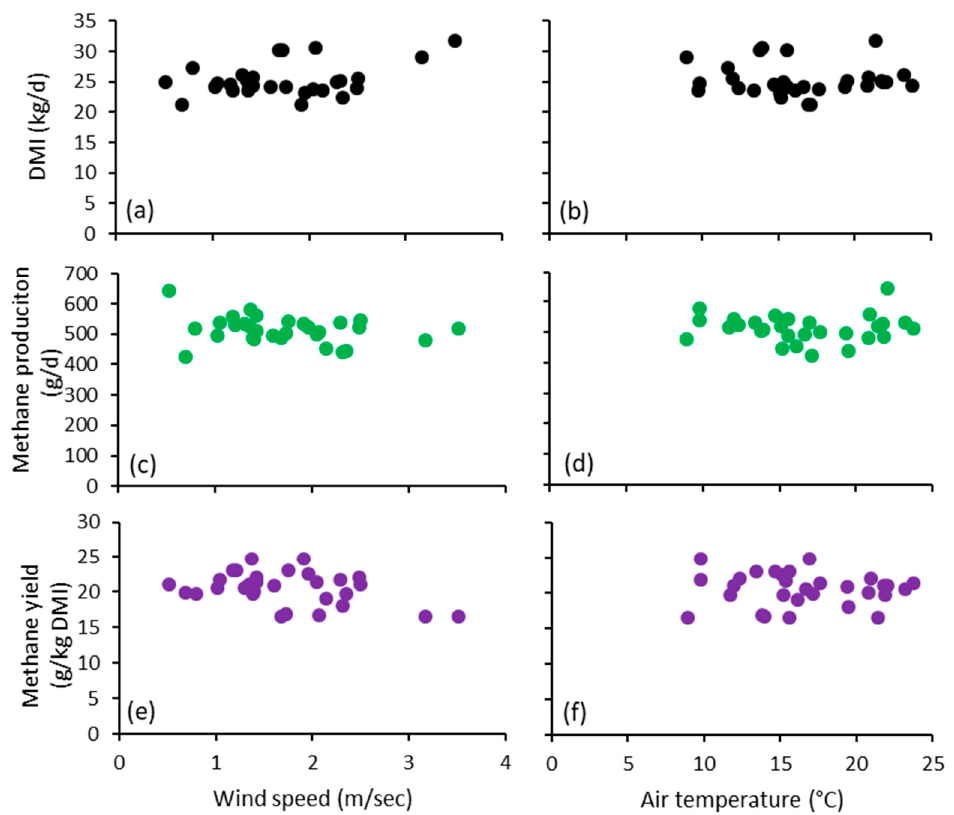
Figure 3. Dry matter intake as influenced by ( a ) mean daily wind speed, and ( b ) mean daily air temperature; methane production (MeP) as influenced by ( c ) mean daily wind speed, and ( d ) mean daily air temperature; methane yield (MeY) as influenced by ( e ) mean daily wind speed, and ( f ) mean daily temperature. Note, each datum depicted is the mean of data from 40 individual cows.